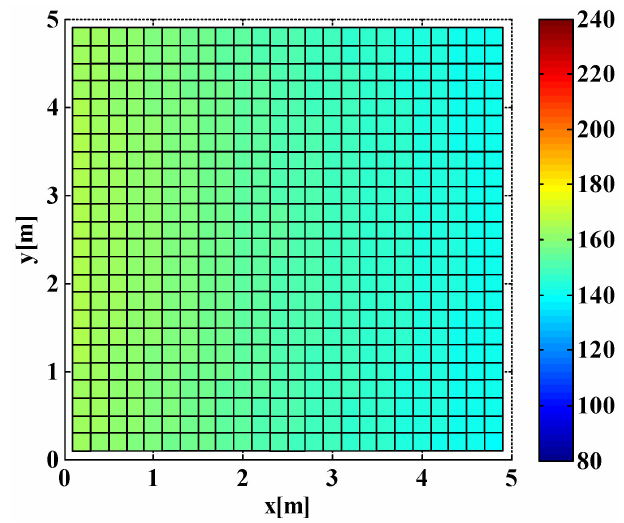
Figure 8. RF link throughput spatial distribution for typical application